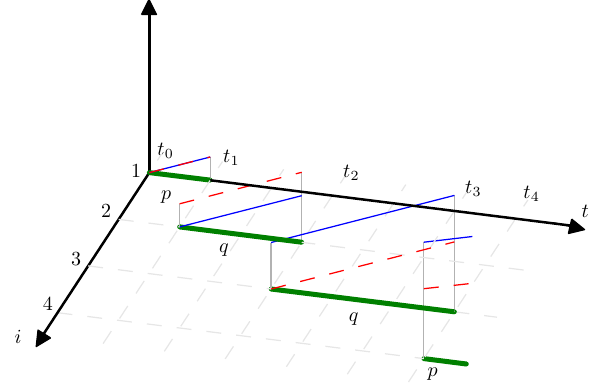
Figure 3: Trajectory of Run 1 in Example